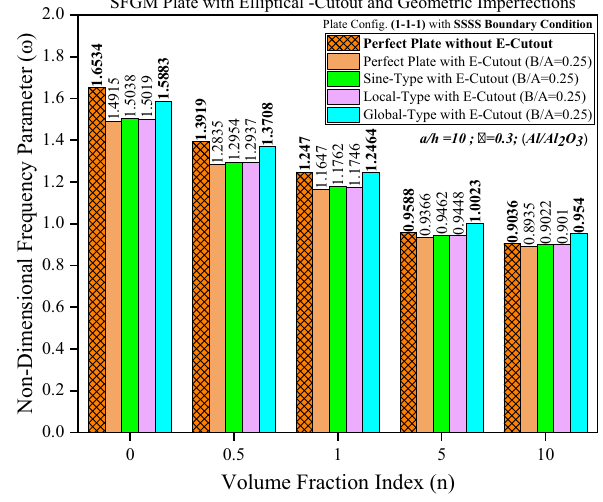
Figure 12: Comparison of the NDFP of SFGM square plate with elliptical cutout and geometrical imperfections under the SSSS BC using ( 1 - 1 - 1 ) plate con fi